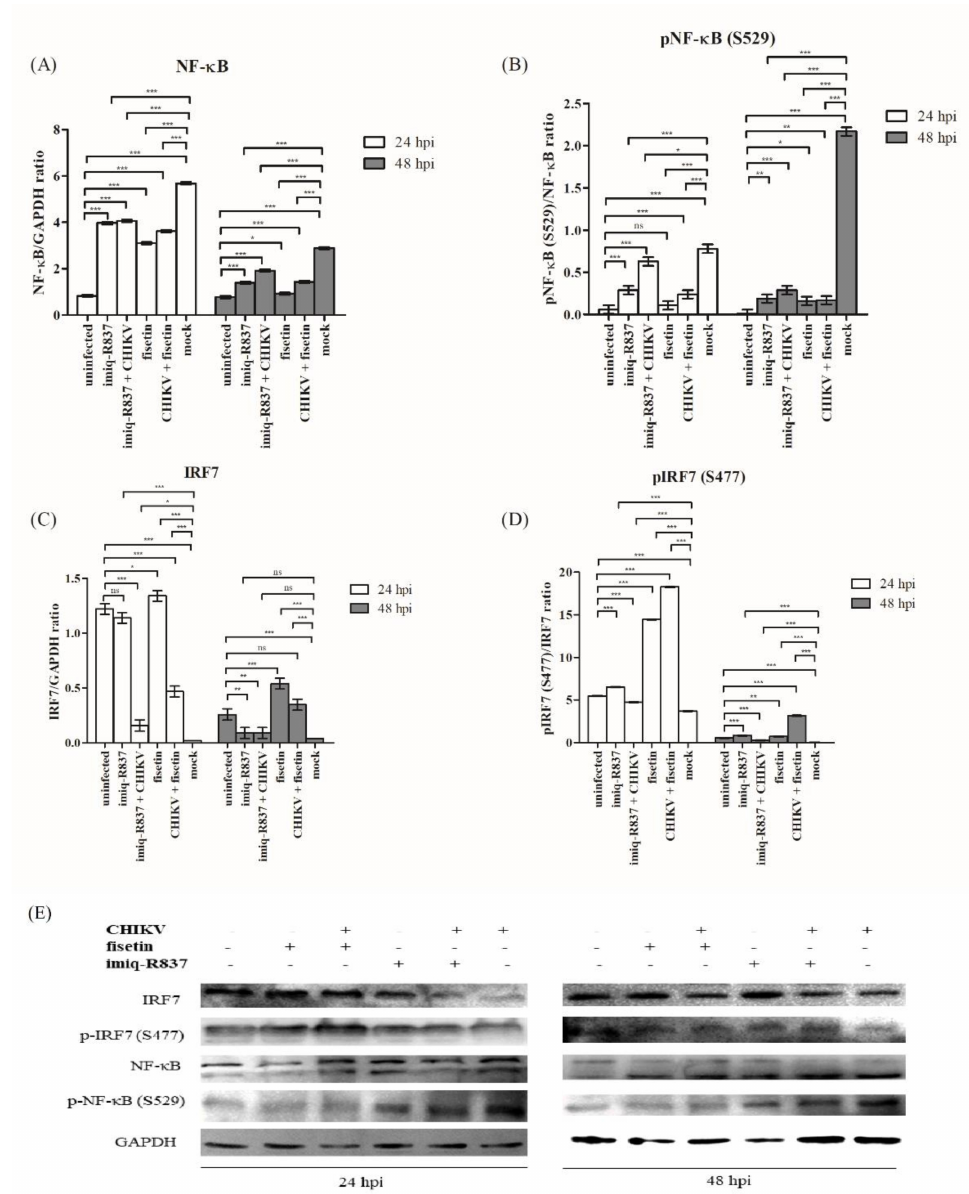
Figure 7. The expression of the transcription factors in the TLR7 pathway. Both ( A ) NF- κ B and ( C ) IRF7 are analyzed relative to GAPDH, while ( B ) pNF- κ B (S529) is relative to NF- κ B expression, and ( D ) pIRF7 (S477) in relative to IRF7. The blots were as in ( E ). CHIKV infection was performed using MOI = 1. Data are representative of triplicates and values are expressed as mean ± SD. One-way ANOVA ( p < 0.0001) and Dunnett multiple comparison post-test (* is p < 0.05, ** is p < 0.01 and *** is p < 0.001) were performed by setting uninfected and mock Huh7 cells of respective time point as an independent